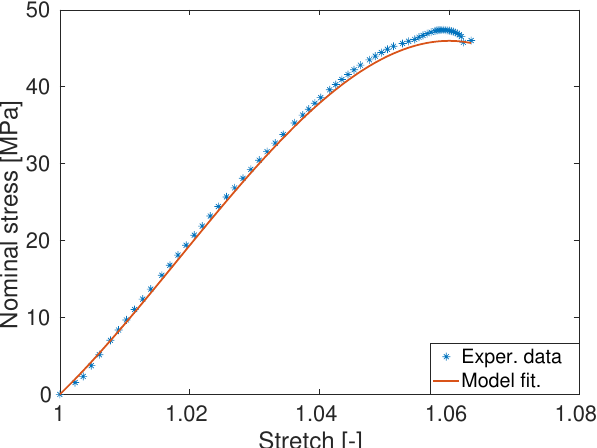
Figure 8. Identification of Carrol model parameters a , b , c using the stress-strain experimental data obtained from the unfilled PET polymer.